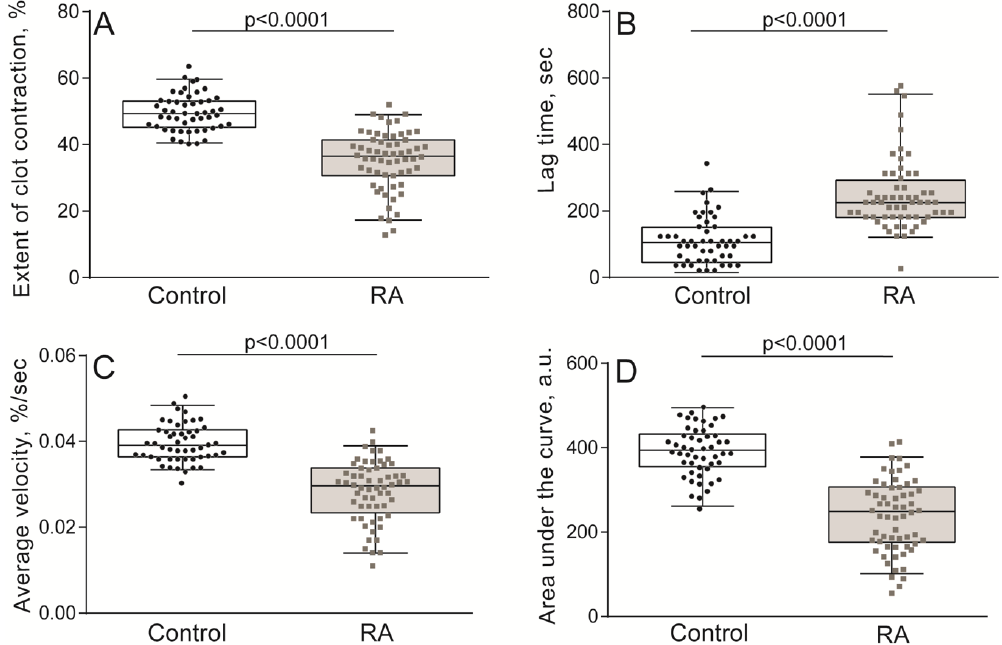
Figure 3. Quantification of blood clot contraction in RA patients ( n = 60) compared with those of the control group ( n = 50). The extent of clot contraction ( A ), lag time of contraction ( B ), average velocity of contraction ( C ), and area under the curve (work performed by platelets in contraction) ( D ). The results are presented as the median and intervals between the 25th and 75th, as well as between the 5th and 95th percentiles (Mann-Whitney U test).